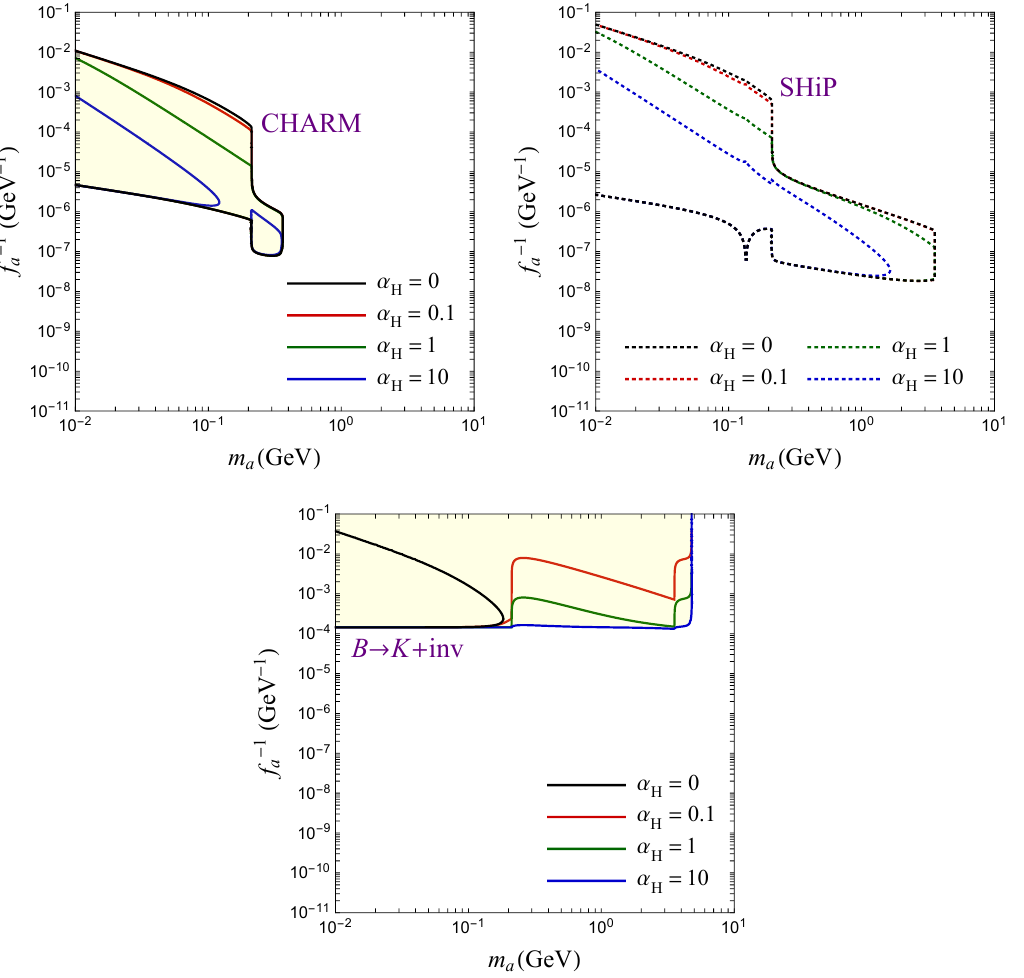
Figure 3 . The e(cid:11)ects of the decay channel a ! (cid:13) panel), the SHiP experiment (upper right-panel), and B 0 decaying into K 0 (bottom) with di(cid:11)erent choices of (cid:11) yellow shaded regions are excluded by current experiments. We set f H = f a , for